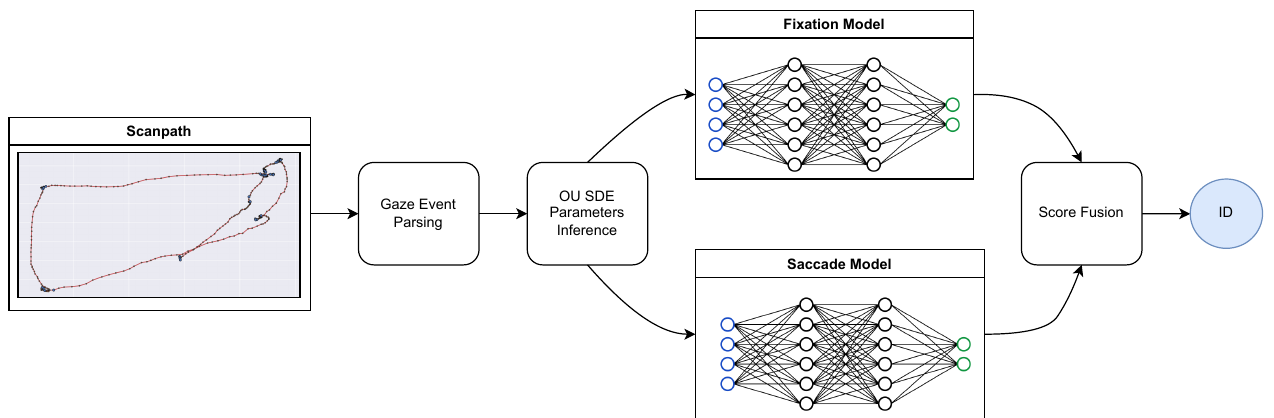
Figure 4. The proposed approach at a